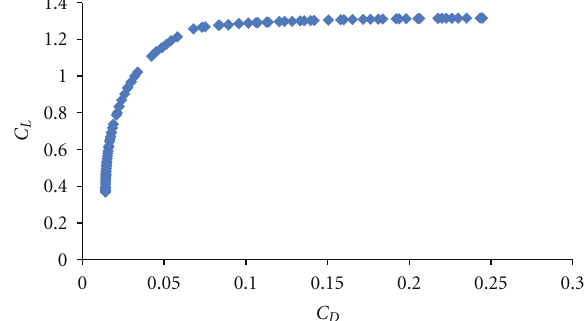
Figure 8: Integrated pressure coe ffi cient of NACA 63-421 airfoil at di ff erent Re.